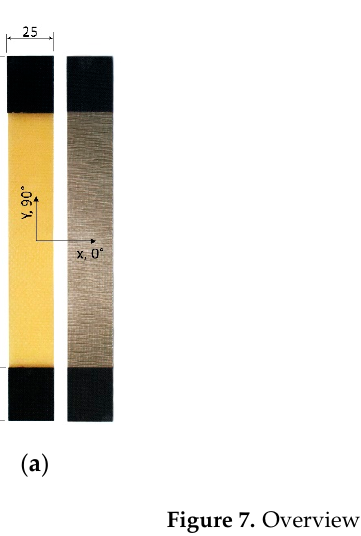
( c ) Figure 6. Overview of the three manufactured laminated configurations: ( a ) reference GFRP; ( b ) AlGFRP-1, containing work-hardened wire; ( c ) AlFGFRP-2 (work-hardened) and, equivalently, AlFGFRP-3 (soft-annealed). 3.1.3. Test Specimens Three different types of specimens, as depicted in Figure 7, were fabricated. Concern- ing the characterization of both the reference laminate and the AlFGFRP laminates, trans- verse (90°) tension specimens (Figure 7a) and longitudinal (0°) tension specimens (Figure 7b) were fabricated according to DIN EN ISO 527-5 [35]. However, due to the limiting dimensions of the winding plate, slight changes to the tab and gauge lengths had to be made. For the combined electrical-mechanical tests, a specimen containing electrical con- tacts was designed (Figure 7c). While the gauge length was equal to the standard length,